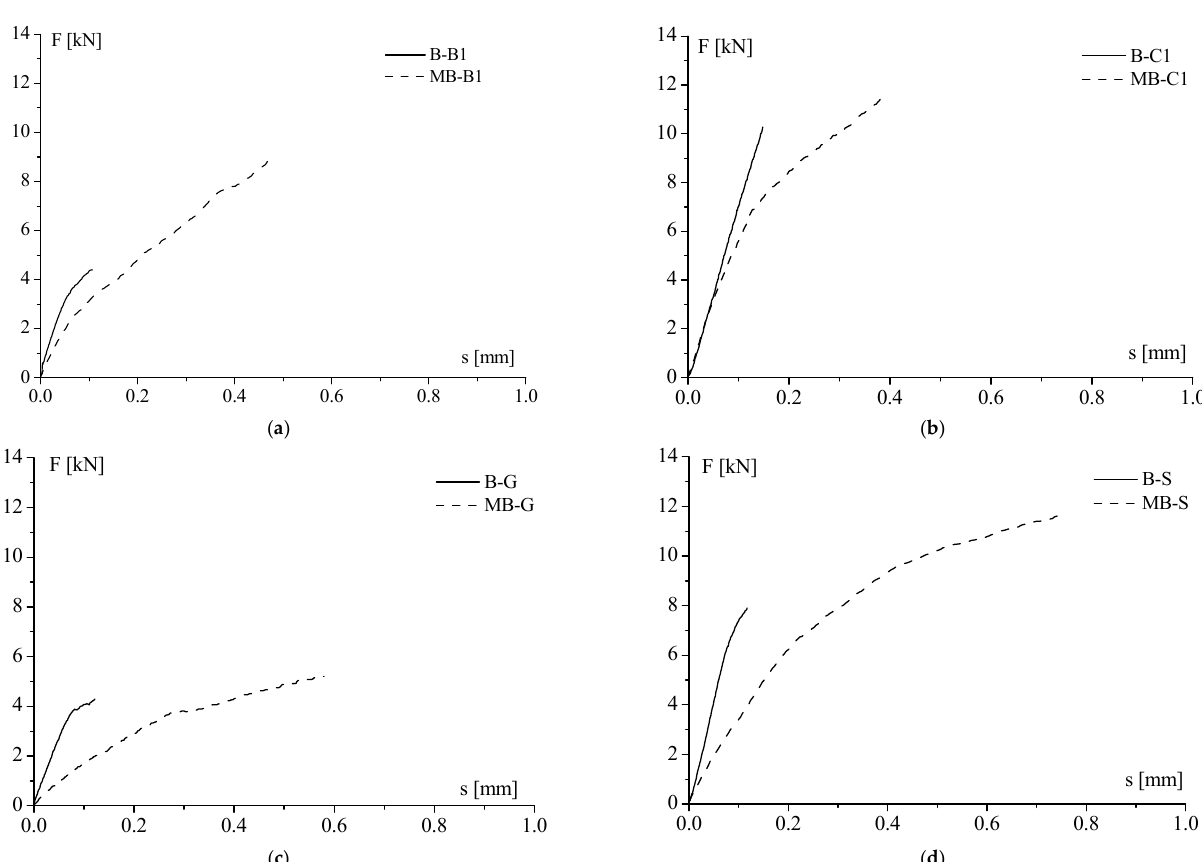
Figure 8. Comparison between average load–slip curves of clay unit and clay masonry, reinforced by ( a ) BFRP-1; ( b ) CFRP-1; ( c ) GFRP; ( d ) SRP.